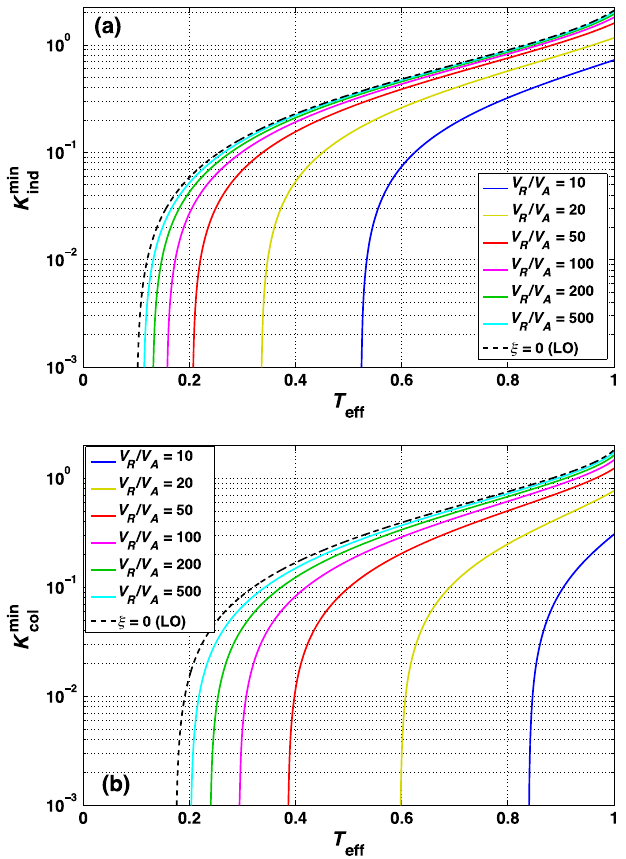
FIG. 3. Expected minimum key rates for the SR-CV-QKD protocol, secure against (a) individual attacks and (b) collective T η . The attacks, as functions of the effective transmittance T eff ¼ 0 . 01 (all in parameter values used are V A ¼ 40 , ε ¼ 0 . 01 , V el ¼ shot-noise units), β ¼ 0 . 95 , δ R ¼ 1 . As shown in the legend, different curves correspond to different values of the reference- pulse amplitude V 1 = 2 R (specifically, V R =V A ¼ f 10 ; 20 ; 50 ; 100 ; 200 ; 500 g ), along with the curve for ξ ¼ 0 , in which case the key rate is the same as that for the respective conventional CV-QKD protocol with LO transmission. The curves terminate on the left at values of T below which the expected secret key rate is zero. eff